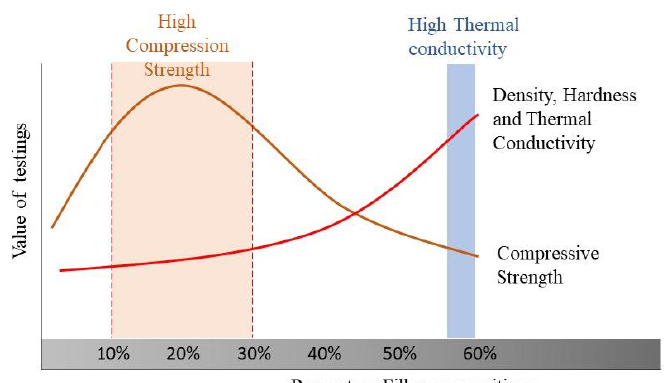
Figure 16. Summary of trend results.